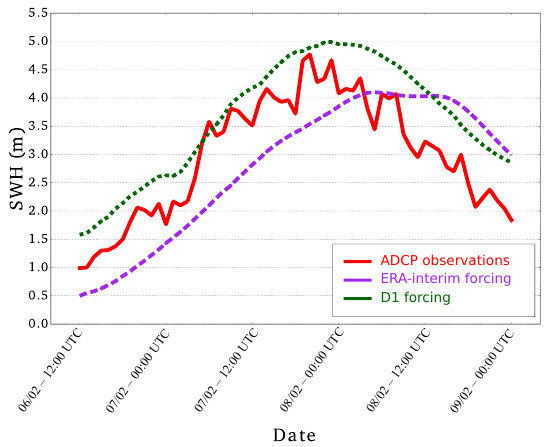
Figure 6. Comparison of the simulated significant wave heights using the two wind inputs (downscaled wind input D1 and ERA- Interim) with the data by ADCP located on the western Black Sea coast at 20m depth during the storm of 7–8 February 2012. ADCP location coordinates: 43 ◦ 04 (cid:48) 49 (cid:48)(cid:48) N, 28 ◦ 01 (cid:48) 40 (cid:48)(cid:48) E. Purple and green stand for ERA-Interim and D1 forcing, respectively. The red line represents the ADCP